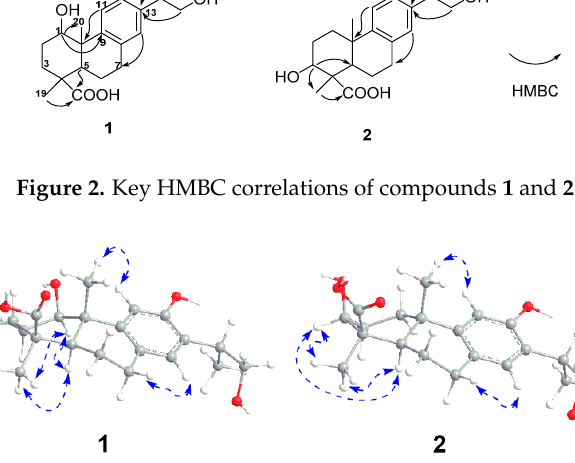
Figure 3. Key NOESY correlations of compounds 1 and 2 . Table 1. 1 H- and 13 C-NMR data ( δ in ppm) for compounds 1 and 2 .